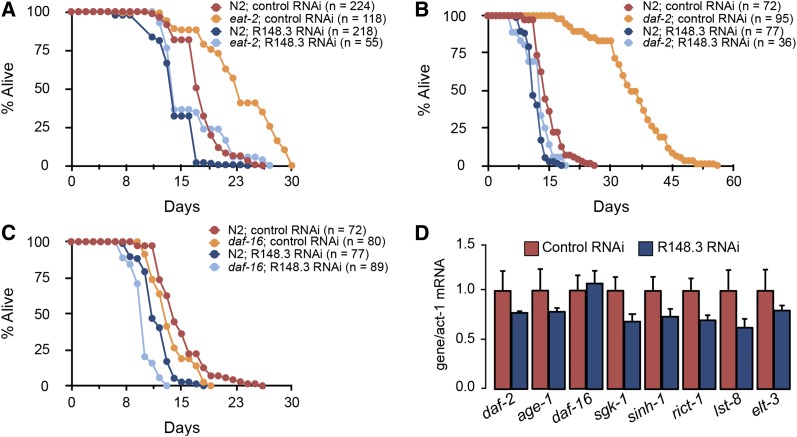
Loss of R148.3 blunts the long-lived phenotype of eat-2 and daf-2 mutants. (A) Representative population survival curve of N2 worms and eat-2 mutants fed either empty vector or R148.3 RNAi (P < 0.0001). (B) Representative population survival curve of N2 worms and daf-2 mutants and fed either empty vector or R148.3 RNAi (P < 0.0001). (C) Survival curve of N2 or daf-16 mutants fed either empty vector or R148.3 RNAi (P < 0.0001). (D) mRNA expression levels of genes involved in the IISP in adult worms fed either empty vector or R148.3 RNAi. See Tables S7–S9 in File S2 for additional data on replicate survival experiments.